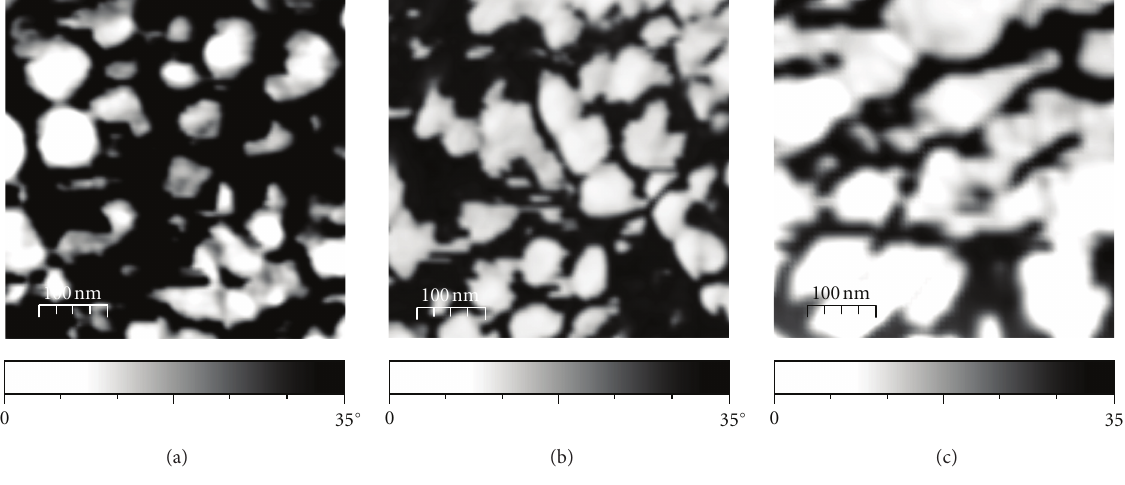
F 8: Mechanical contrast images of MCAP (a), MCAP6.25 (b), and MCAP12.5 (c).